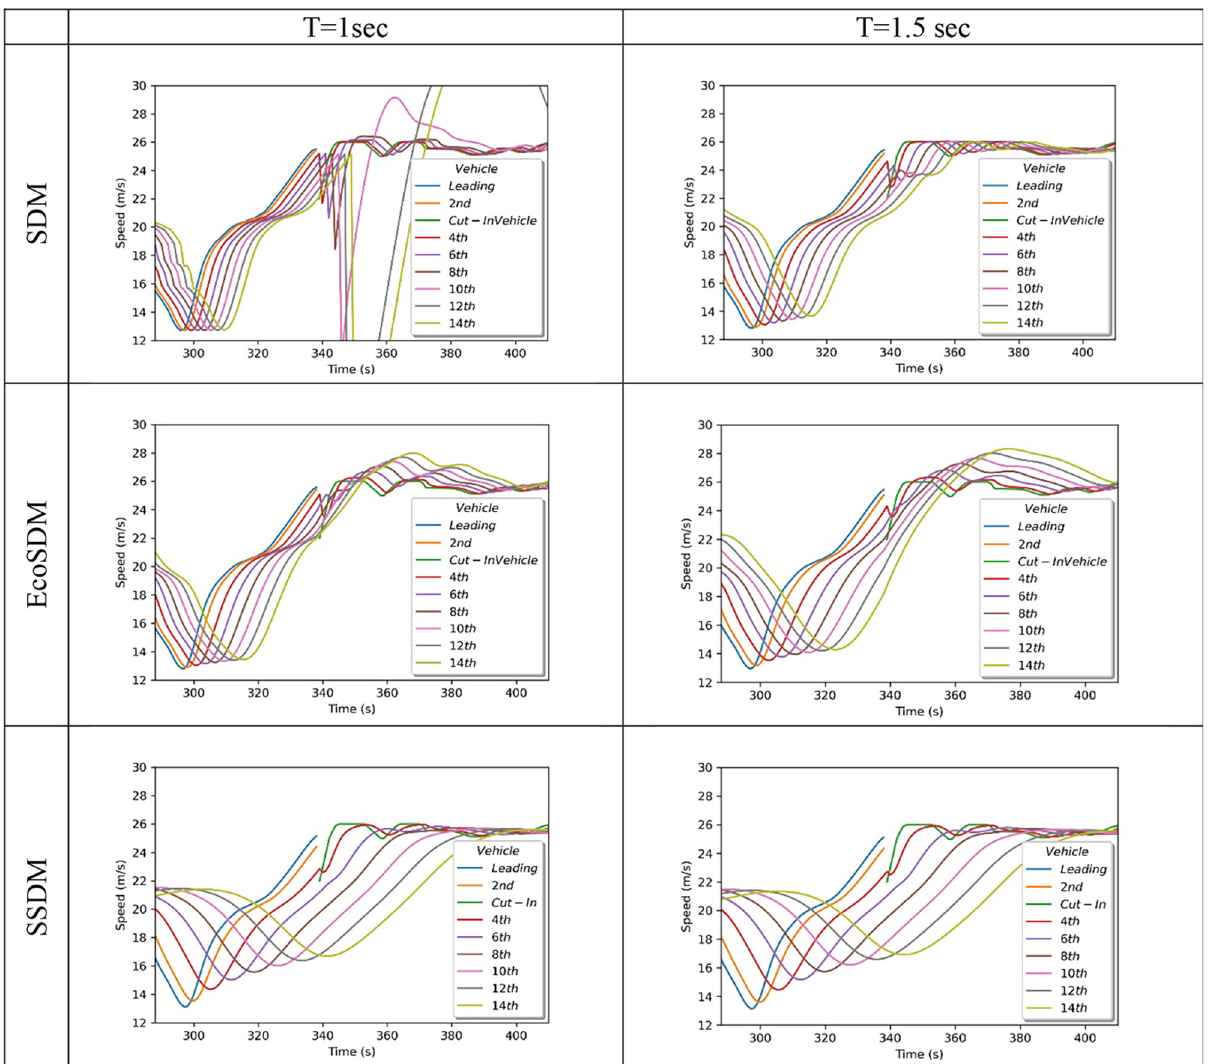
Figure 1 Acceleration pro fi les of vehicles equipped with SDM, EcoSDM and SSDM under cut-in situation considering different desired time